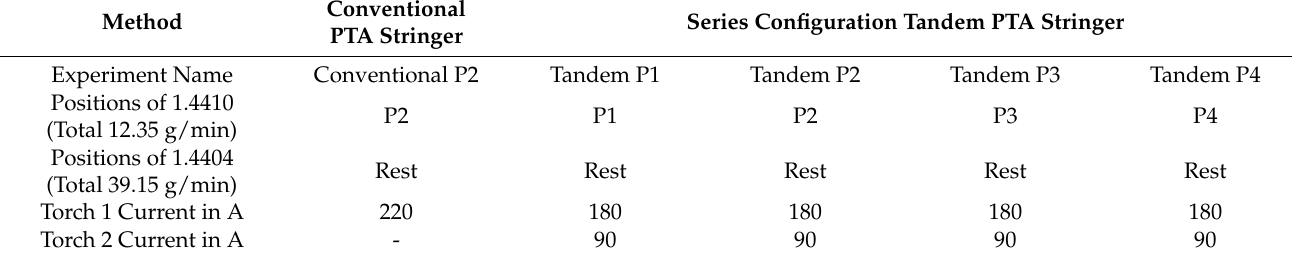
Table 5. Powder position and current values of experiments for multi-material coating .